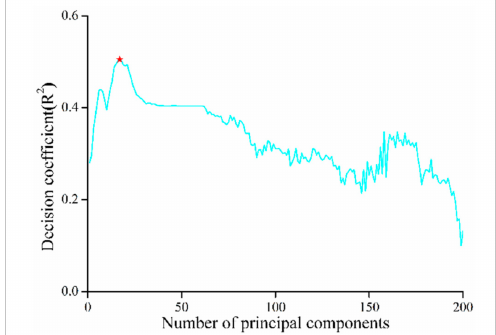
Figure 9. Model determination coe ffi cient changes with the number of principal